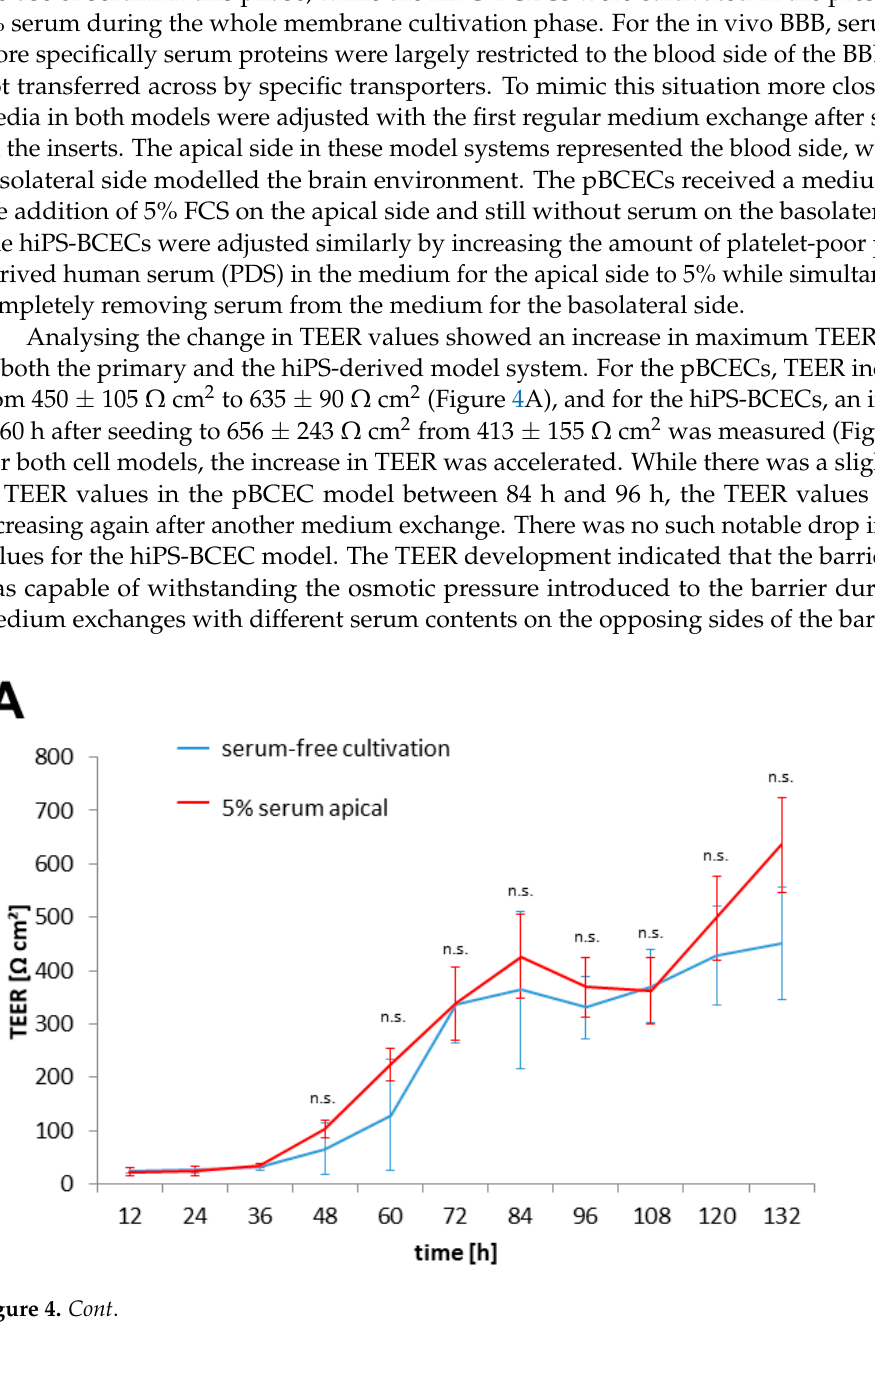
Figure 4. TEER development in reaction to a change in serum contents in the media. ( A ) pBCECs were seeded on collagen-coated Transwell ® inserts with 3.0 µm pore size after isolation. TEER val- ues were measured continuously. The medium was exchanged 24 h after seeding with either culture medium (serum-free, blue line) or culture medium with 5% FCS on the apical side and serum-free culture medium on the basolateral side (red line). Data shows mean ± S.D. at 12 h intervals for at least three biological replicates. ( B ) After 8 days of differentiation, hiPS-BCECs were seeded on col- lagen IV–fibronectin-coated membrane inserts with 3.0 µm pore size and TEER was measured con- tinuously. The medium was exchanged 24 h after seeding with either endothelial medium without growth factors (1% PDS, black line) or with enriched endothelial medium (5% PDS) on the apical side and endothelial medium without serum on the basolateral side (red line). Data shows mean ± S.D. at 12 h intervals for at least three biological replicates; n.s. p > 0.05. This increase in TEER values was also reflected in the permeability coefficients. The permeability of sodium fluorescein in both model systems was lowered to values smaller